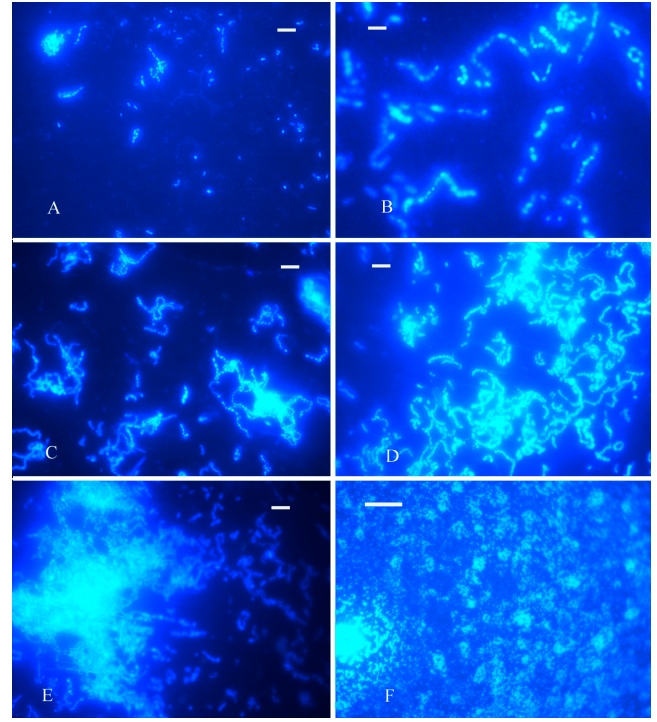
Figure 1. Fluorescence images of bacterial cells colonized titanium specimens in the S. sanguis inoculated enriched artificial saliva after various exposure times ( A ) 24 h; ( B ) 72 h; ( C ) 120 h; ( D ) 168 h; ( E ) 336 h; ( F ) magnified view of the local biofilm in ( E ). Scale bar is 50 μ m.